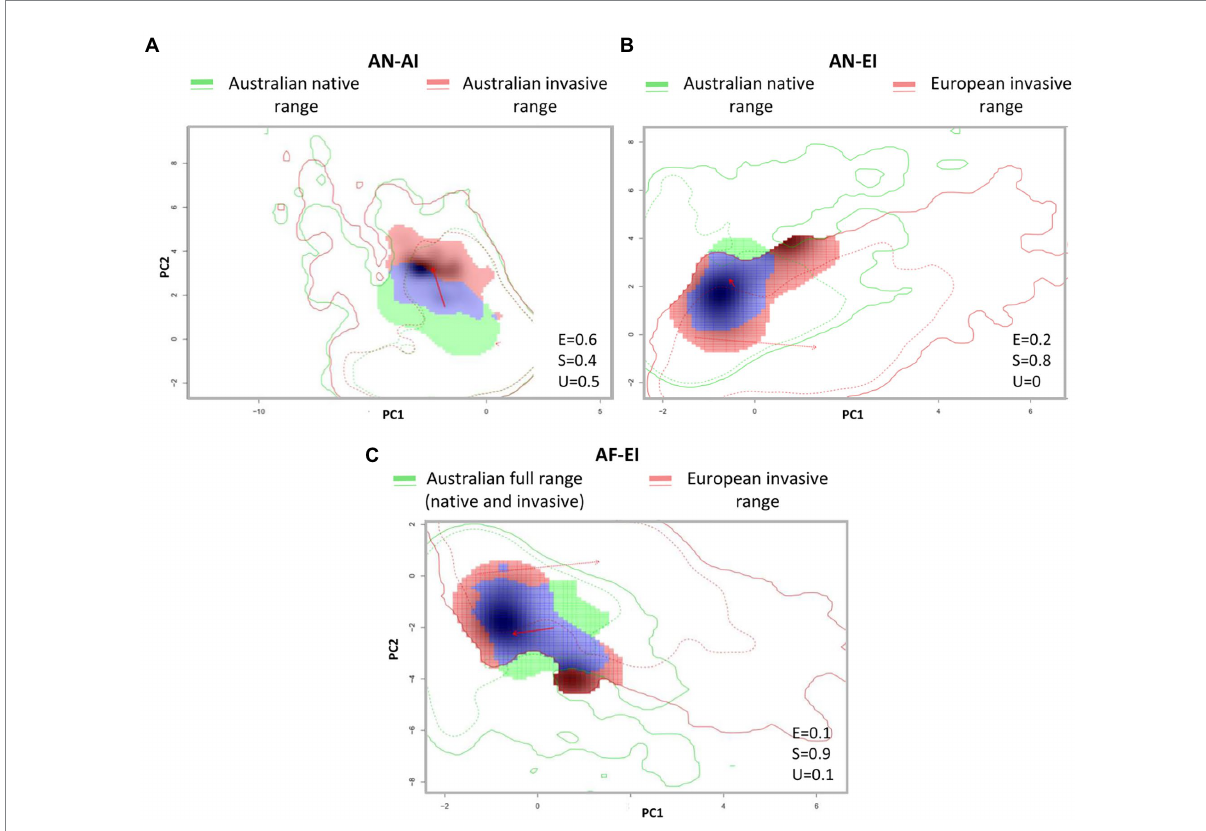
FIGURE 2 Niche overlaps and dynamics of Paraserianthes lophantha between its native and introduced ranges in climatic space: (A) From Australian native range to Australian invaded range (AN-AI comparison). (B) From Australian native range to European invaded range (AN-EI). (C) from the Australian full range to the European invaded range (AF-EI). Solid and dotted contour lines represent 100 and 50% of the available environmental conditions that exist in the niche A (green lines) and niche B (red lines). Green areas represent climates only occupied in niches A (unfilling areas), blue areas represent climates occupied in niches A and B (stability areas) and red areas represent climates occupied only in niches B (expansion area). Shading indicates the species density in niche B. The red arrows show how the environmental centroid of the species niche (solid) and the background conditions (dotted) changes between